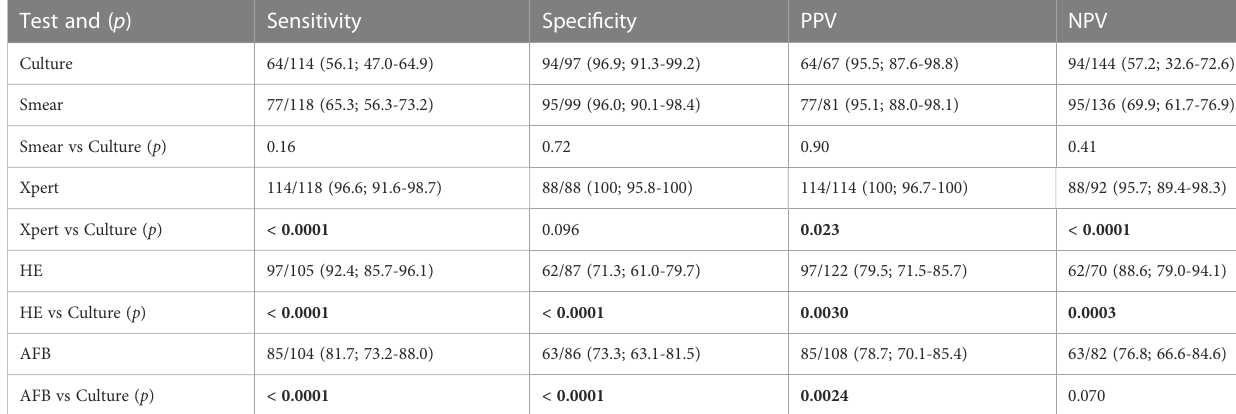
TABLE 2 Diagnostic utility of culture, smear, Xpert, HE, and AFB in the examination of biopsy samples. Test and ( p )